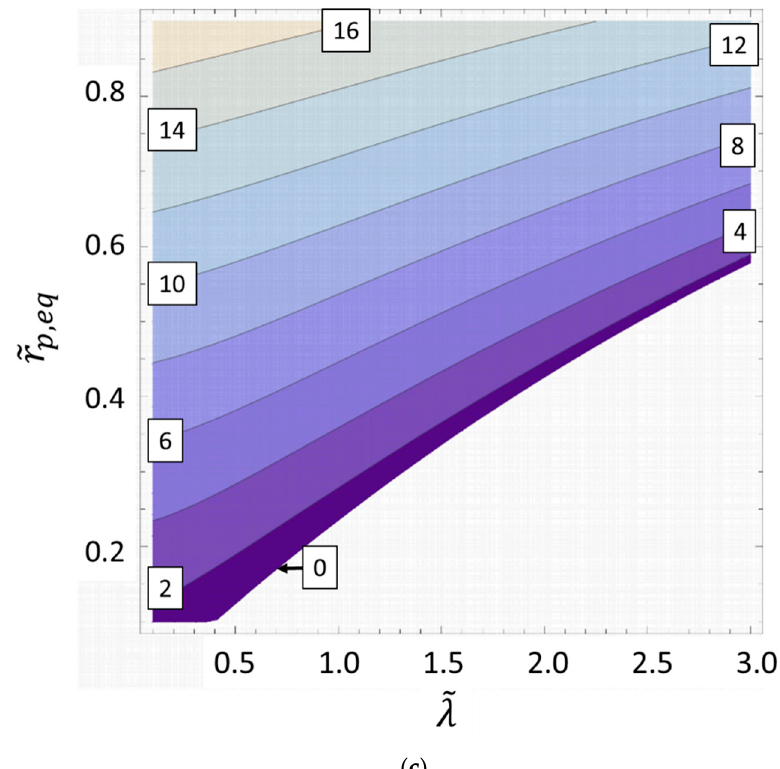
Figure 8. Time duration ∆ (cid:101) t II of the diffusion-controlled regime II as a function of the relaxation time (cid:101) λ and the gas transfer rate (cid:101) g for (cid:101) r p , eq = 0.4 ( a ) , the dimensionless equilibrium radius (cid:101) r p , eq and gas transfer rate (cid:101) g for (cid:101) λ = 2 ( b ) , as well as (cid:101) r p , eq and (cid:101) λ for (cid:101) g = 0.1 ( c ) . The values of ∆ (cid:101) t II are indicated at the contour lines. The white areas represent the absence of region II, i.e., the surface-tension-driven regions I and III merge, without a diffusion-controlled regime in between.